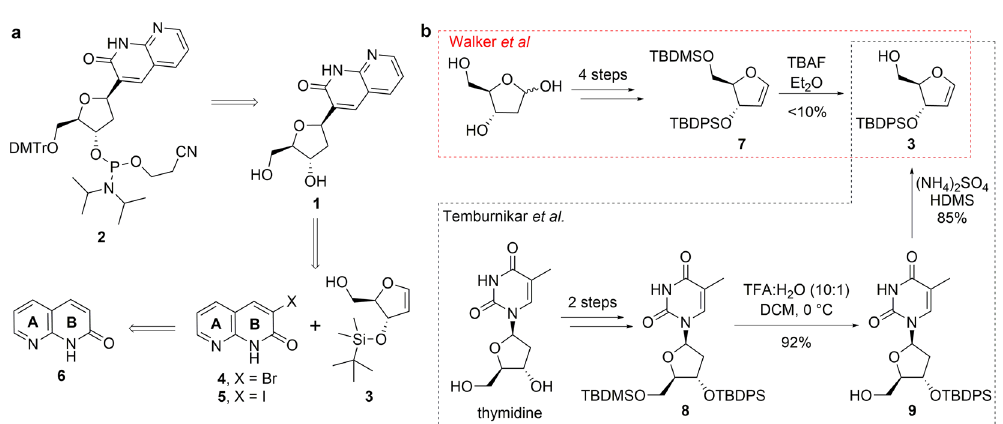
Figure 2. ( a ) Retrosynthetic analysis. ( b ) Synthetic routes to the glycal 3 20,21